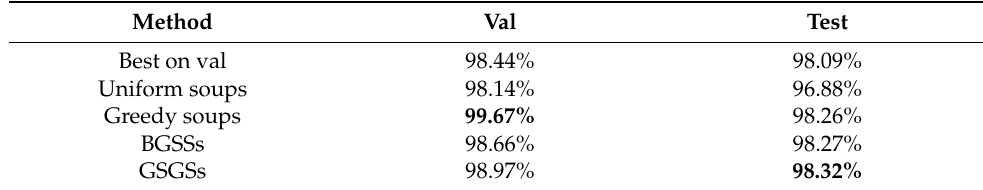
Table 3. Comparison of the val and test accuracies of the proposed and existing methods for CIFAR10. Greedy soups has the highest val accuracy, but the lowest test accuracy among the proposed methods. The gap between the val accuracy and test accuracy of greedy soups is large. However, the proposed method GSGSs has the highest test accuracy compared to the other methods. The gap between the val accuracy and test accuracy of GSGSs is not as large as that of greedy